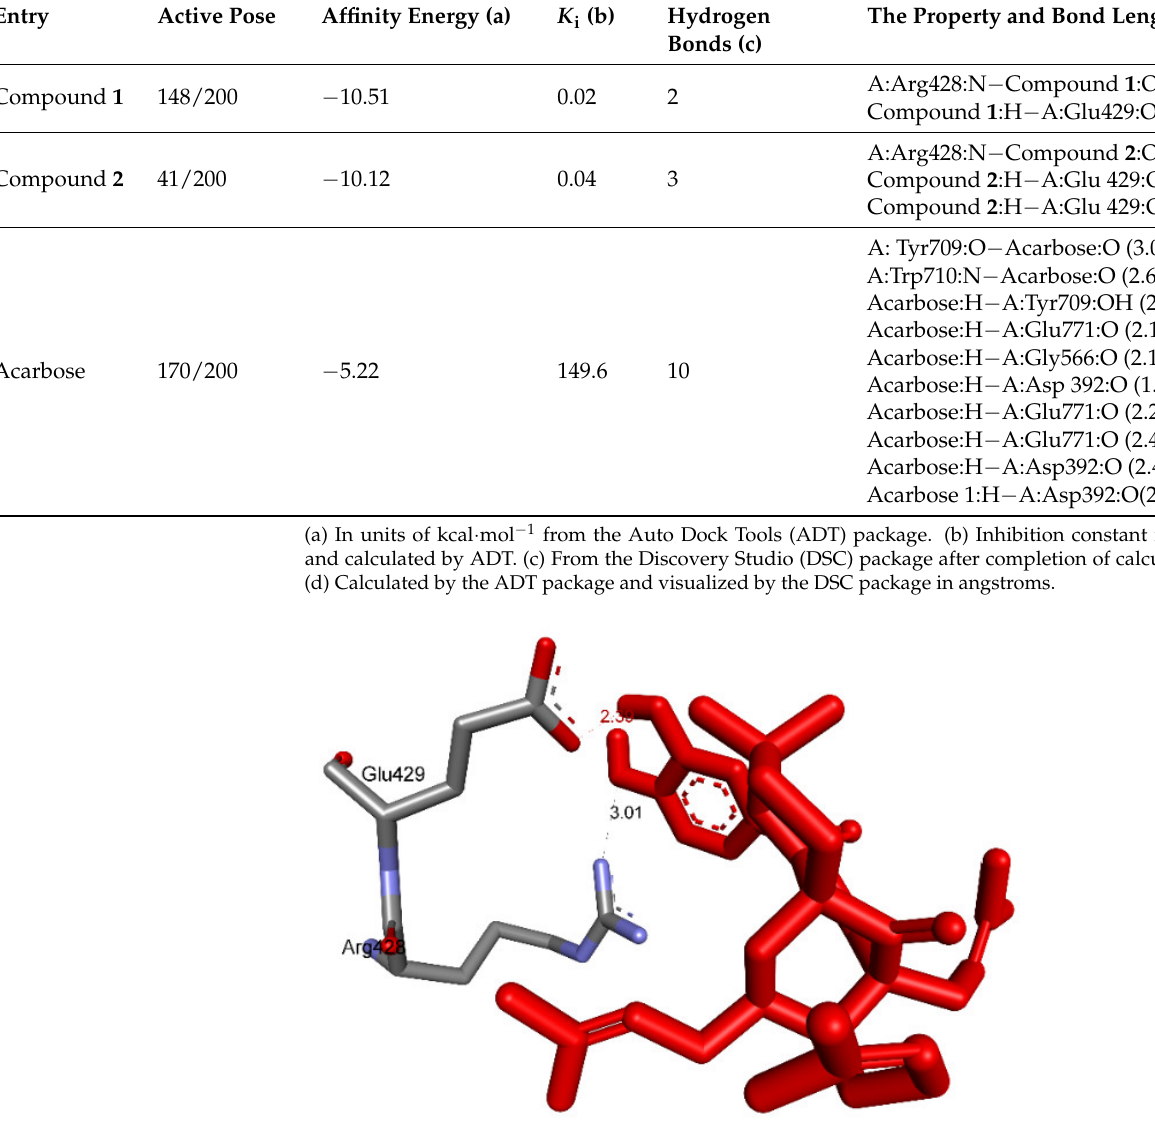
Figure 4. The most significant ligand interactions between compound 1, pose 148 and receptor 4J5T (PDB), a member of the α-glucosidase enzyme family.